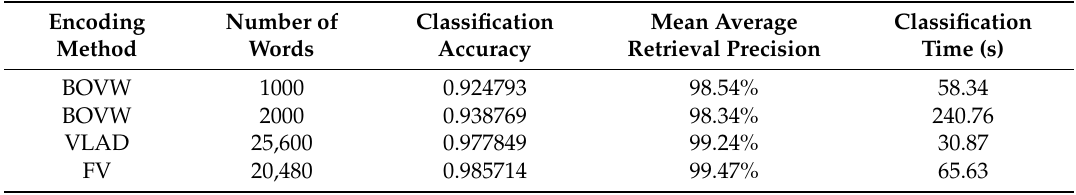
Table 4. The classification accuracy for the lobby dataset.